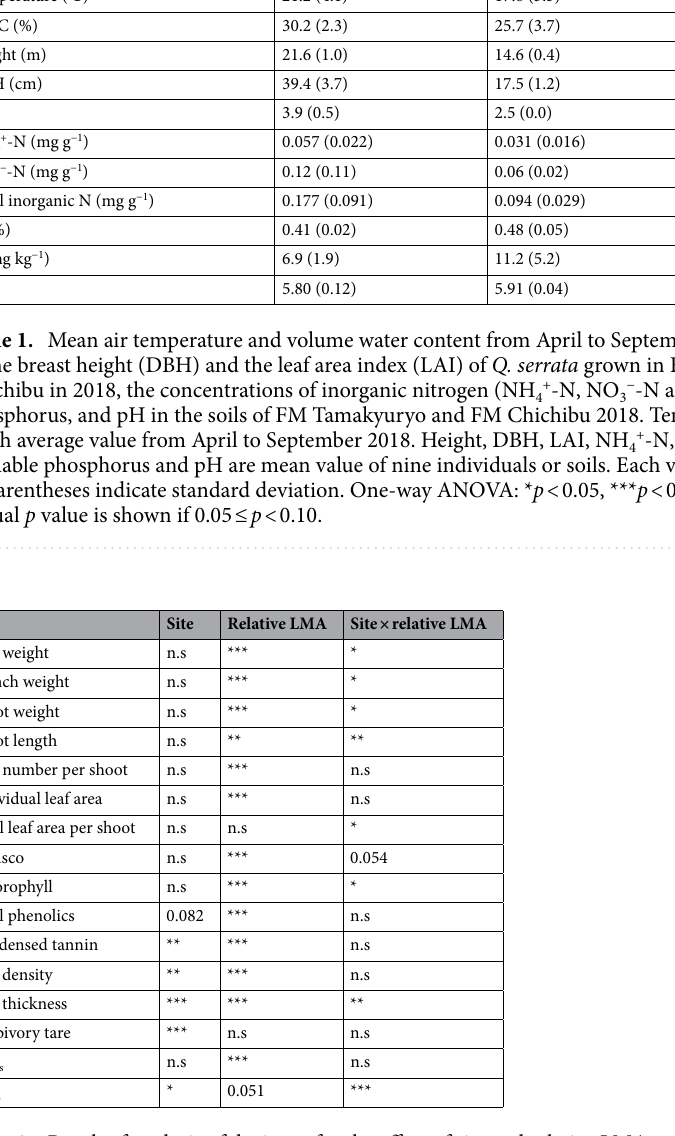
Table 2. Result of analysis of deviance for the effect of site and relative LMA on leaf weight, branch weight, shoot weight, shoot length, leaf number per shoot, individual leaf area, total leaf area per shoot, Rubisco, chlorophyll, total phenolics, condensed tannin, leaf density, leaf thickness, herbivory rate, N mass and P mass of Q. serrata grown in FM Tamakyuryo in July 2018 and FM Chichibu in August 2018. * p < 0.05, ** p < 0.01, *** p < 0.001, n.s. not significant. Actual p value is shown if 0.05 ≤ p <